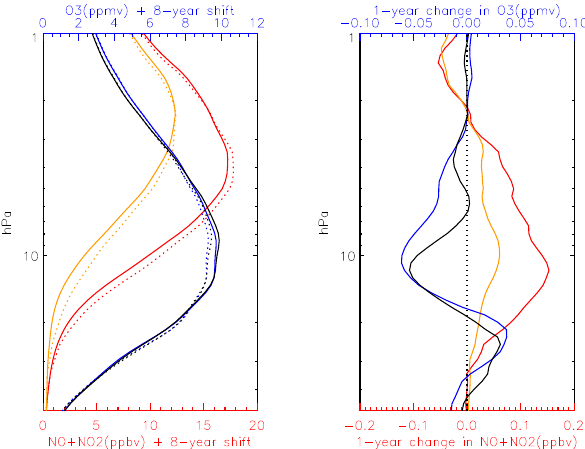
Figure 9. Left hand panel: annual average HALOE profiles of O 3 at local sunset (blue; top scale), local sunrise (black; top scale) and NO + NO 2 at local sunset (red; bottom scale), and local sunrise (or- ange; bottom scale) from 5 ◦ S to 5 ◦ N. Results are shown for the first year of HALOE measurements (solid) and with an 8-year shift (to allow for comparison with Fig. 7) using the annual average trend shown on the right-hand panel (dashed). Right hand panel: 1-year changes based on linear trends over 5 ◦ S–5 ◦ N calculated from 1991 to 2005. Line colors are the same as in the left-hand